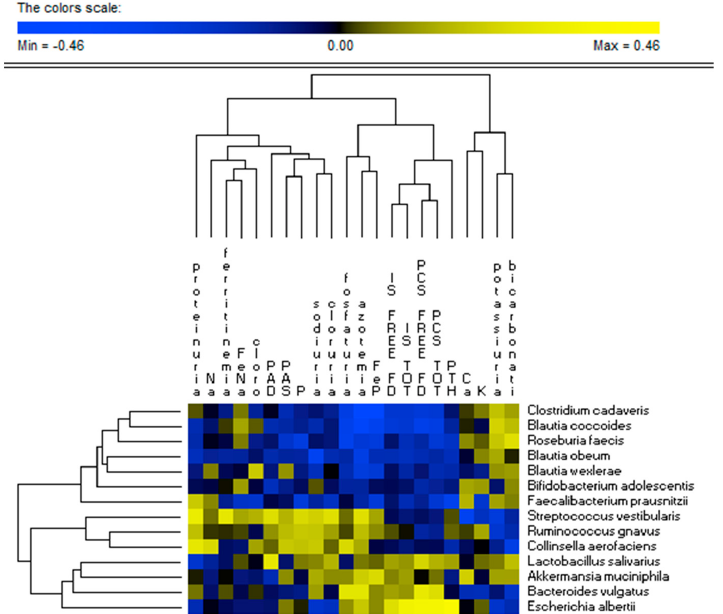
Figure 8. Correlations between bacterial species and serum metabolome of CKD patients. The colors of the scale bar denote the nature of the correlation, with 1 indicating a perfectly positive correlation (yellow) and − 1 indicating a perfectly negative correlation (blue) between species and dietary intake. Only significant correlations (FDR, 0.05) are